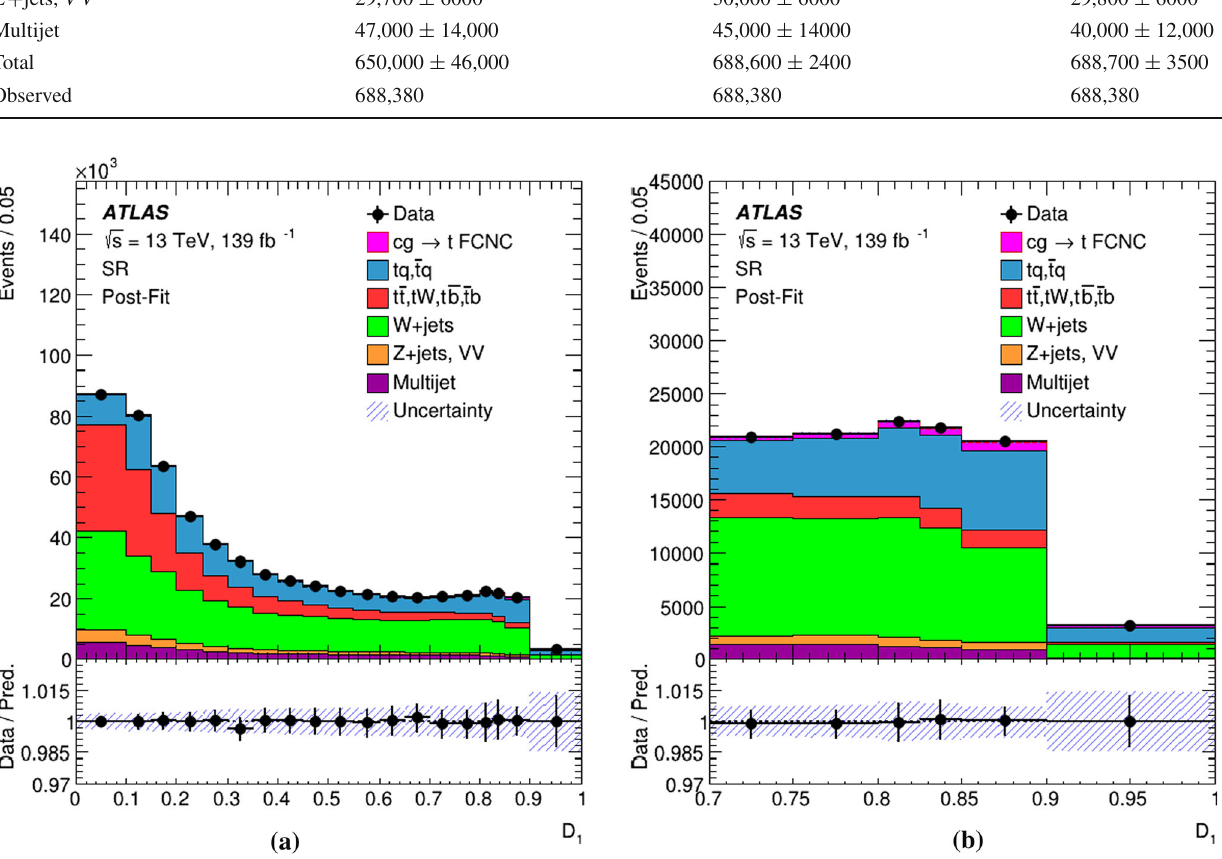
Fig. 7 The NN discriminant D 1 of the cgt search is shown with the post-fit normalisation applied to the stacked histograms of the differ- ent hard-scattering processes. The histogram in a shows the full dis- criminant range. The histogram b shows a zoomed-in view of the high